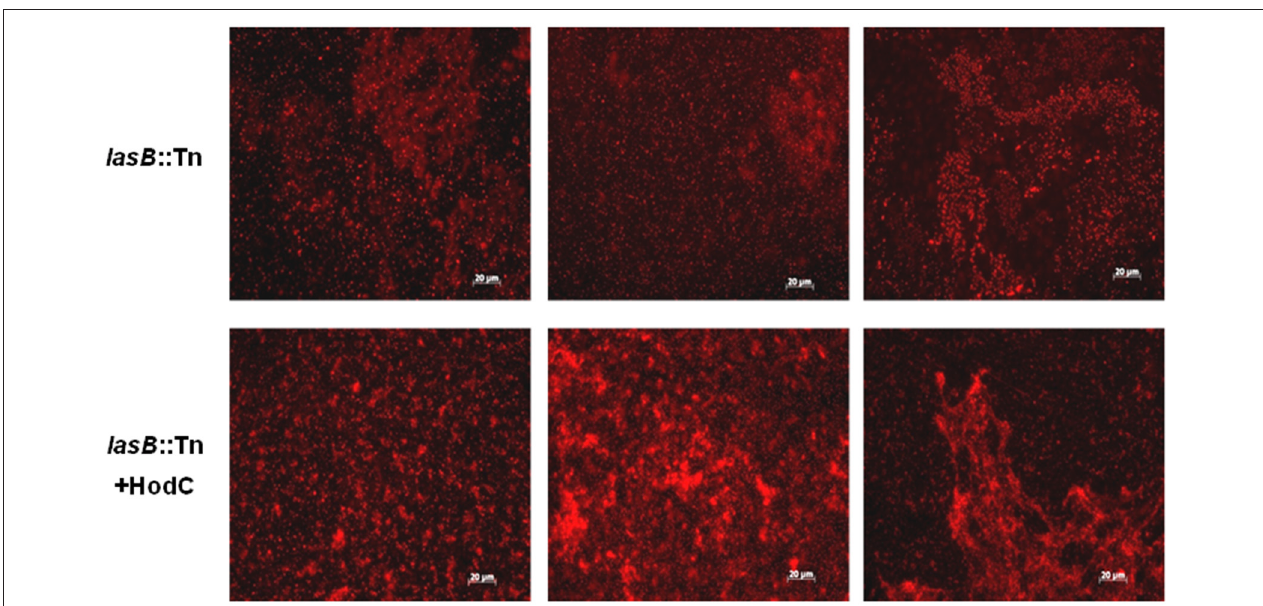
FIGURE 4 | Biofilms of P. aeruginosa PA14 lasB ::Tn in presence and absence of HodC, stained with CTC. Overnight cultures were diluted (10 − 2 ) in LB, supplemented with HodC at a final concentration of 70 U/ml, and the suspensions were used to inoculate glass bottom petri dishes (MatTek, Ashland, USA). After 24 h of incubation at 37 ◦ C under static conditions, planktonic cells were removed by washing with LB medium and the attached viable biofilm cells were stained using 5-cyano-2,3-ditolyl tetrazolium chloride (CTC). Fluorescence microscopy was carried out using an Axioplan 2 imaging system with appropriate filter sets. Experiments were performed in triplicate and representative images are